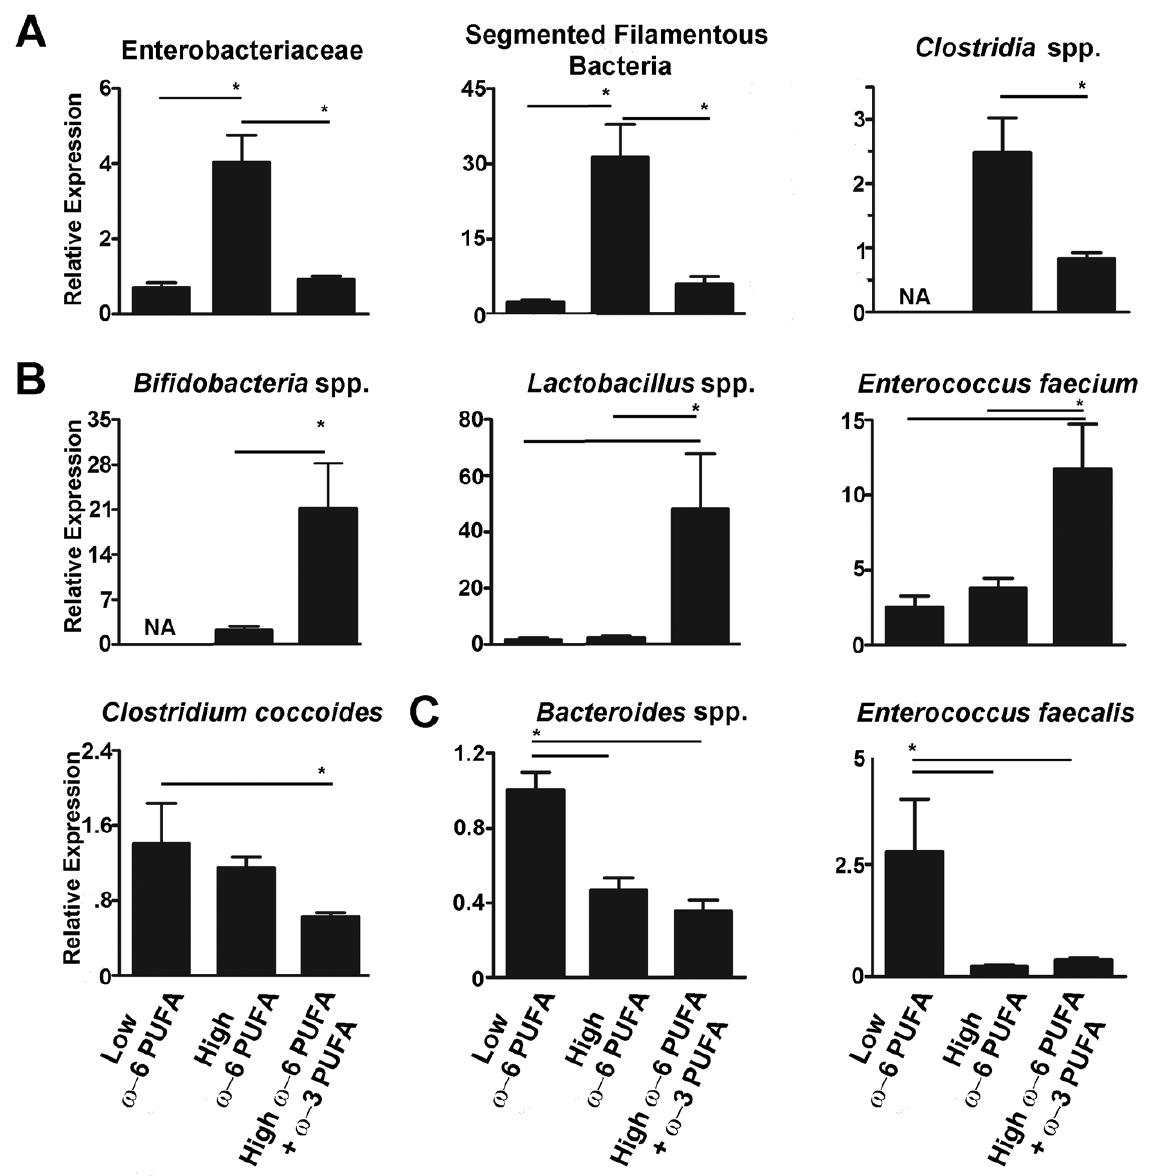
Figure 1. v -6 PUFA rich diets induce dysbiosis and v -3 PUFA supplementation reverses these blooms while enriching beneficial microbes. A) v -6 PUFA rich diets promote a microbiota enriched with Enterobacteriacea, Segmented Filamentous Bacteria (SFB) and microbes